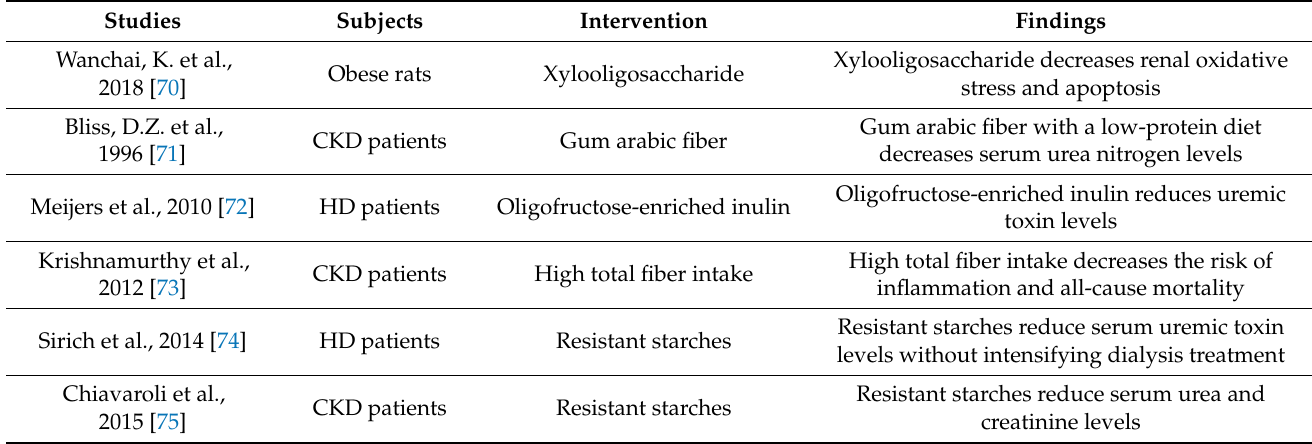
Table 2. Studies evaluating the association between prebiotics and kidney